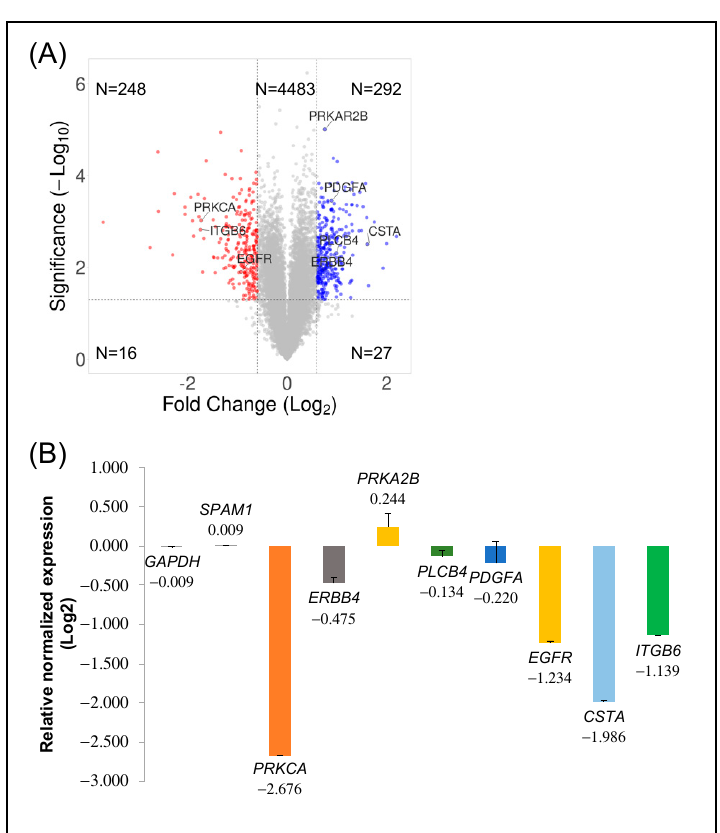
Figure 2. Transcriptomic analysis: ( A ) Volcano plot displaying the expression of probe sets in PKC α - KD vs. PKC α -WT MCF-7 cells. Log 2 fold changes and their corresponding p -values of all genes in the microarray were taken to construct the volcano plot. Genes up-regulated with more than 1.5-fold change with a p -value <0.05 are depicted in blue dots, and those down-regulated with identical fold change and p -value are in red dots. All other genes in the array are not significantly altered and are represented in grey dots. ( B ) Validation of significant up-and down-regulated genes by